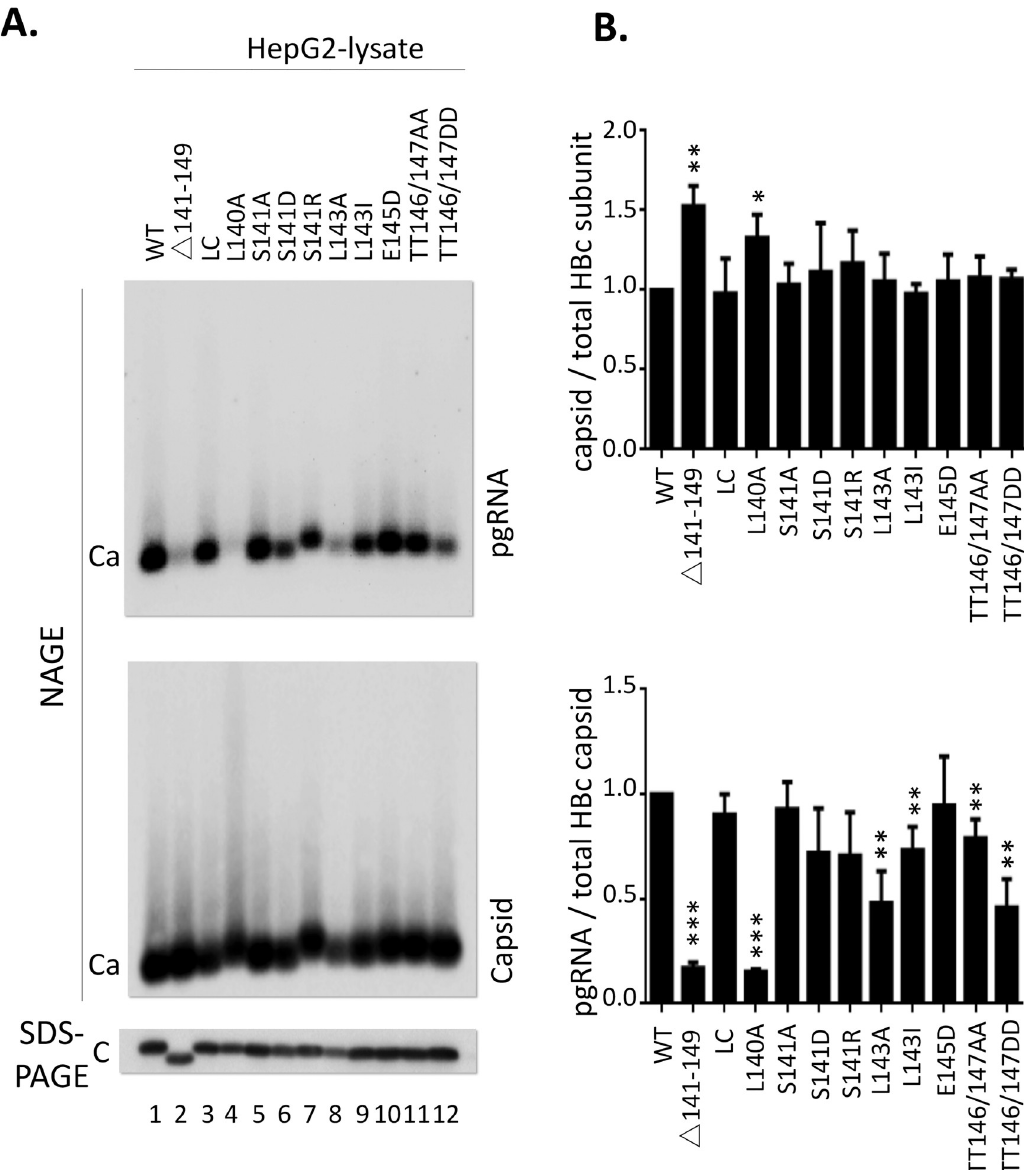
Fig 4. Effect of linker mutations on capsid assembly and pgRNA packaging. HepG2 were co-transfected with the indicated HBc expression constructs and the HBV genomic construct defective in HBc expression and harvested seven days post-transfection. A. Cytoplasmic lysates from the transfected cells were resolved by NAGE and transferred to nitrocellulose membrane. The anti-sense HBV RNA probe and the mAb 1D8 were used to detect packaged pgRNA and assembled capsids respectively (top panel). Total HBc levels were measured, following SDS-PAGE and transfer to PVDF membrane, using mAb 1D8 against HBc NTD (bottom panel). Ca, capsid; C, HBc monomer. B. Quantitative results from multiple experiments shown in A. Capsid assembly efficiency was determined by normalizing the levels of capsids to those of total HBc protein, and RNA packaging efficiency by normalizing the levels of RNA packaging to those of capsids, with the efficiency from WT set to 1.0. � , P < 0.05; �� , P < 0.01; ��� , P < 0.001. 5A /lane 5 and 9/), and S141R showed barely detectable RC DNA signal (Fig 5A /lane 7/). The other linker mutants, S141D, L143A, and TT146/147DD, did not show any detectable mature RC DNA but contained variable levels of immature DS DNA intermediates running as a smear between the SS DNA and RC DNA (Fig 5A /lane 6, 8 and 12/), suggesting these mutants